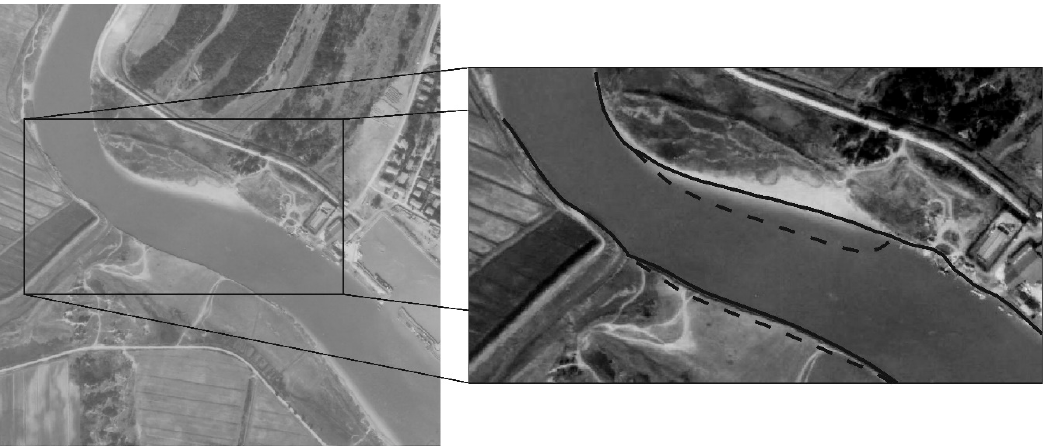
Figure 5. Aerial photograph of the meander in 1983. Shoreline in 1983 (solid line) and in 1988 (dashed line).